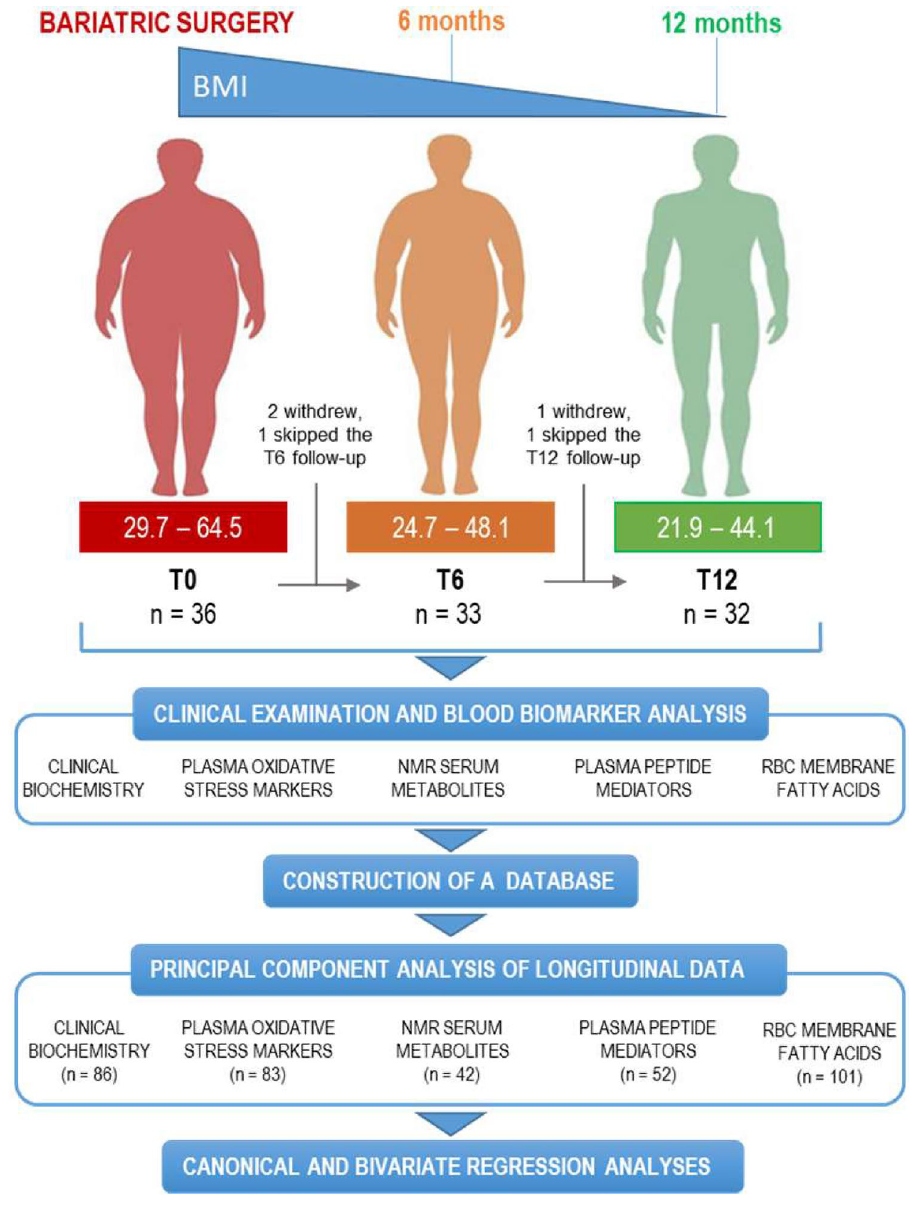
Figure 1. Flow diagram of the study. For each time of the study, the number of patients and the range (min– max) of patients’ BMI are displayed. The number of observations included in PCA analysis for each biomarker dataset is indicated in